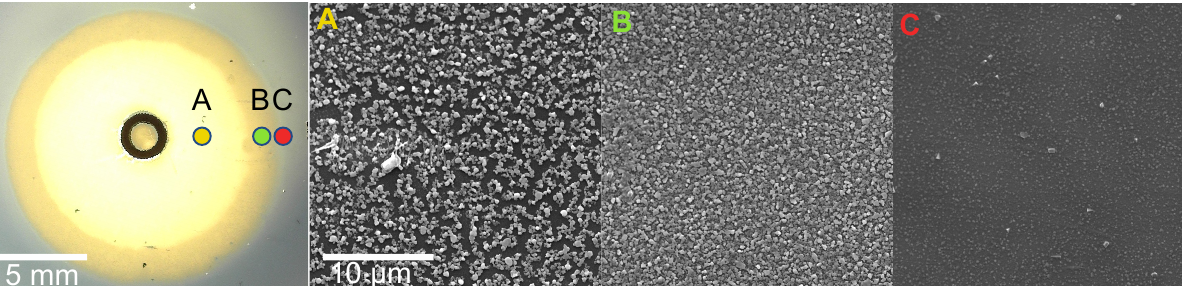
Figure 8. SEM analysis of the corrosion spot (deposition time 90 s without seed layer exposed to 0.5 wt% HCl). The sample was studied using SEM at the center of the colored circles, labeled A , B and C , indicated on the digital microscope image shown at the